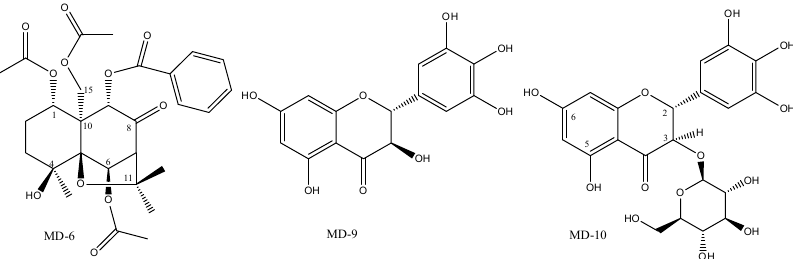
Figure 2. Molecular structures of pure compounds obtained from Maytenus disticha. Maytenus disticha (MD)-6: (5S,5aS,6S,9S,9aS,10R)-5a-(Acetoxymethyl)-5-(benzoyloxy)-9-hydroxy-2,2,9-trimethyl-4 oxooctahydro-2H-3,9a-methanobenzo[b]oxepine-6,10-diyl diacetate. MD-9: Ampelopsin, dihydromyricetin. MD-10: Dihydromyricetin-3-glucosid.